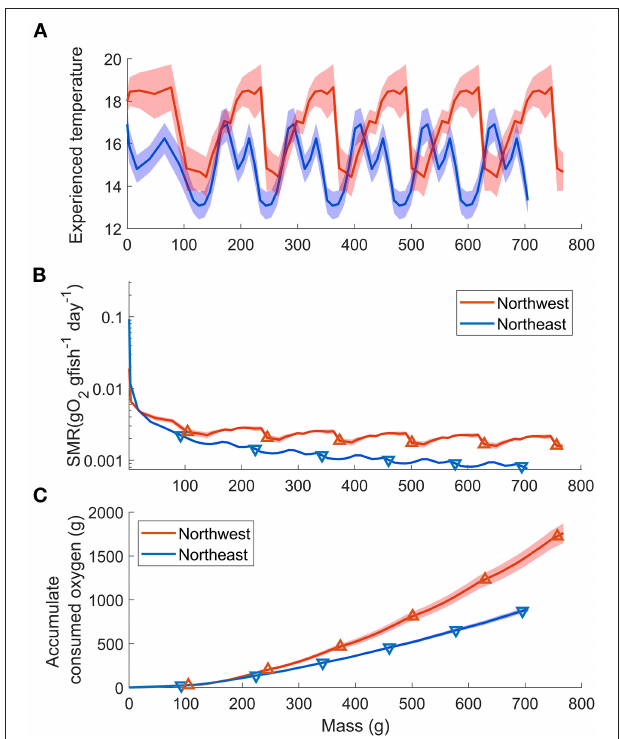
FIGURE 7 | Stock comparisons of the relationship between Pacific chub mackerel mass (growth stage) and (A) experienced temperature (B) SMR (g O 2 g fish − 1 day − 1 ) and (C) accumulate consumed oxygen (g). Red and blue stand for Northwest and Northeast stocks, respectively. Triangle markers in (B) and (C) are values at age 0–5. The colored shadow represents the standard deviation of temperature in (A) and the associated error in (B,C) .